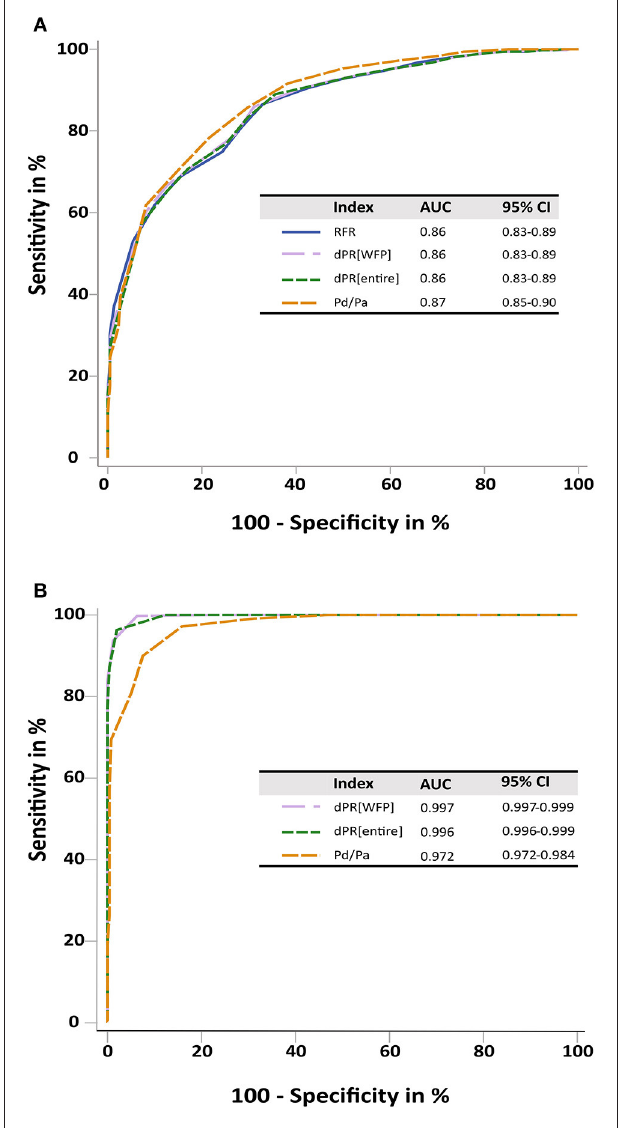
FIGURE 4 | ROC curves. (A) ROC curves for RFR, dPR[entire], dPR[WFP] and Pd/Pa showed a similar performance of all NHPRs tested against an FFR ≤ 0.80. (B) ROC curves for dPR[WFP], dPR[entire], and Pd/Pa tested against RFR ≤ 0.89. All three indexes showed an excellent prediction for RFR defined ischemia, supporting the similar performance of all NHPRs. dPR[entire], diastolic pressure ratio during entire diastole; dPR[WFP], diastolic pressure ratio during wave-free period; FFR, fractional flow reserve; NHPR, non-hyperemic pressure ratio; Pa, aortic pressure; Pd, distal coronary pressure; RFR, resting full-cycle